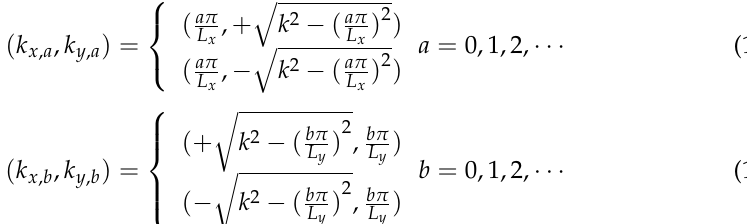
Due to the irregularity of the acoustic cavity, the wave functions are defined in the envelope rectangle shown in Figure 6.